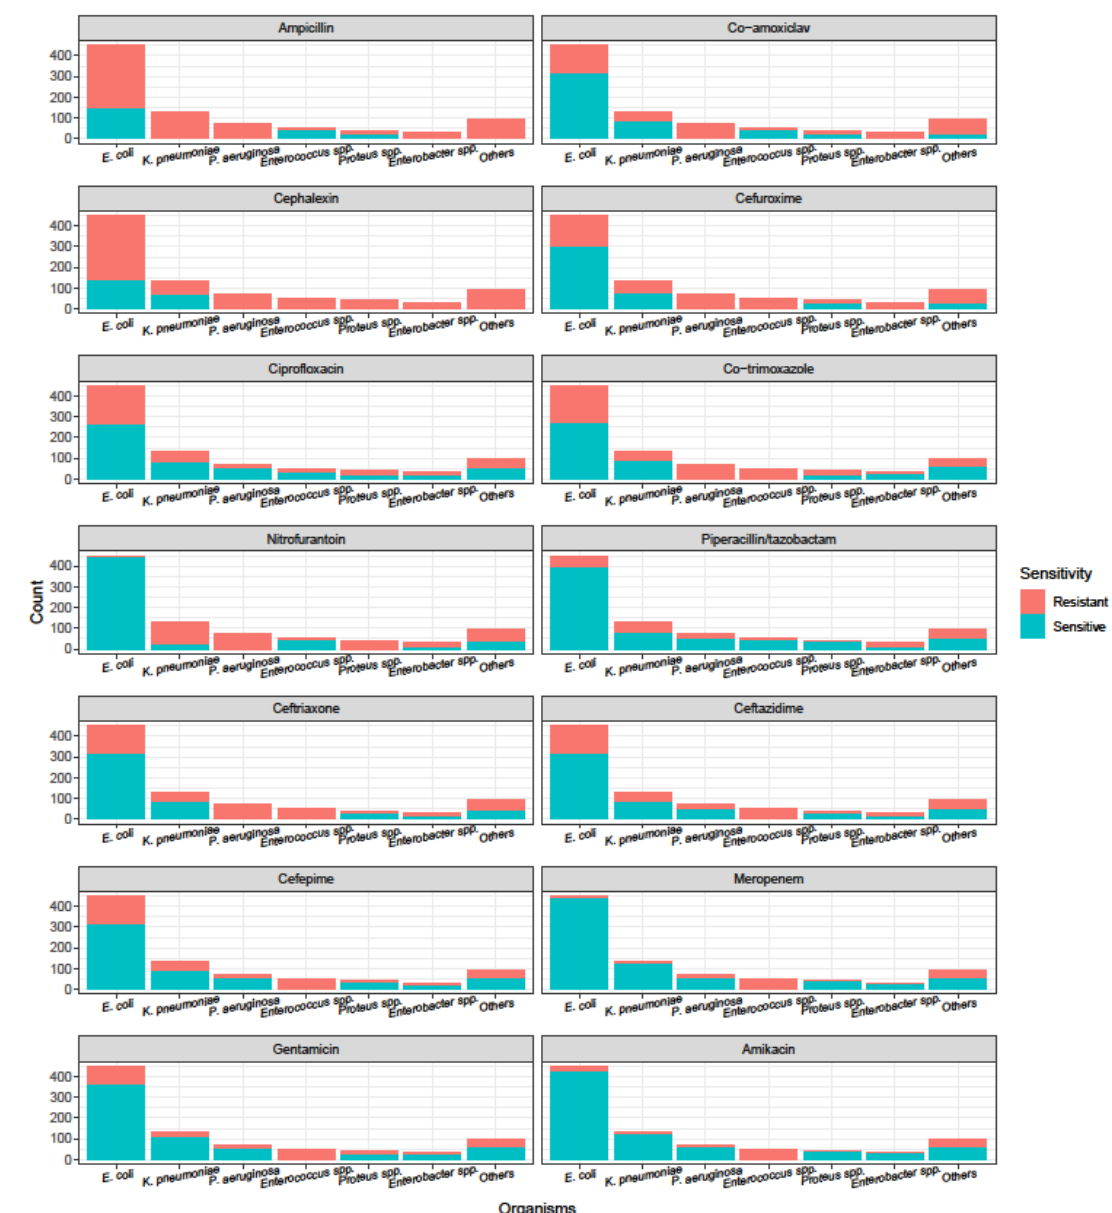
Figure 2. Susceptibility of uropathogens to antibiotics.